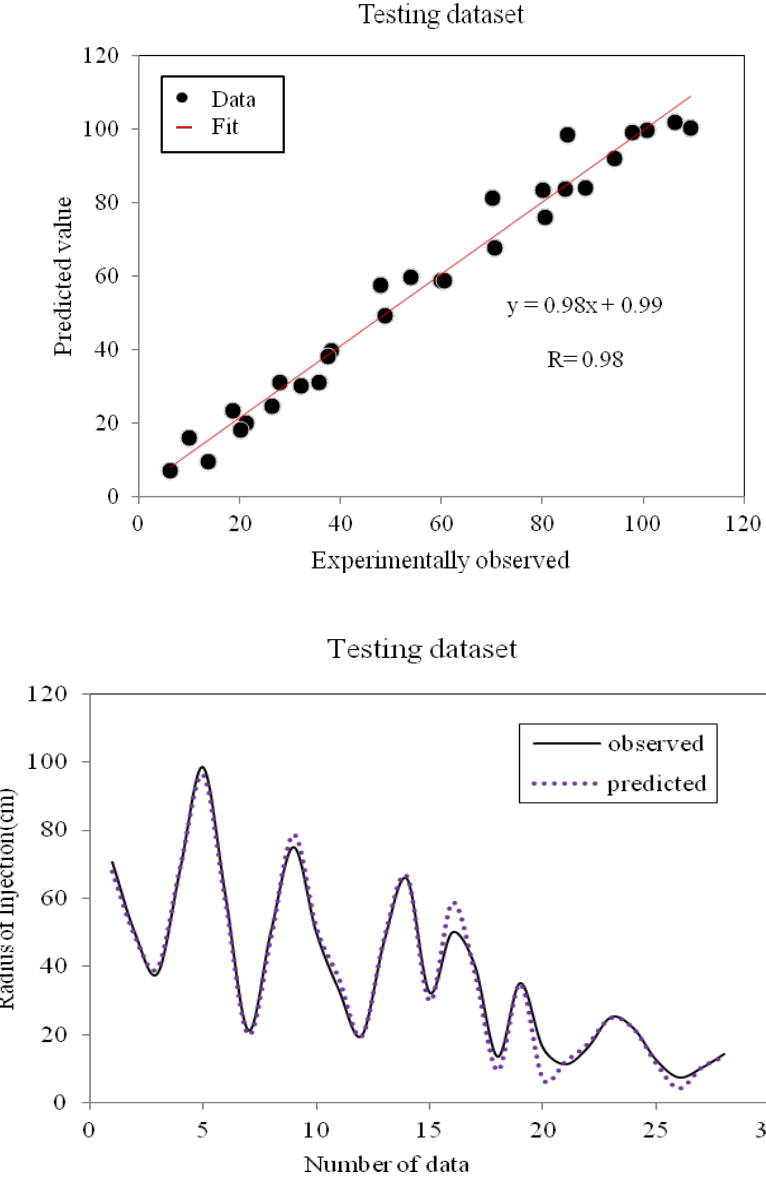
Fig. 9. Comparison of the experimentally observed and ANN predicted values for testing